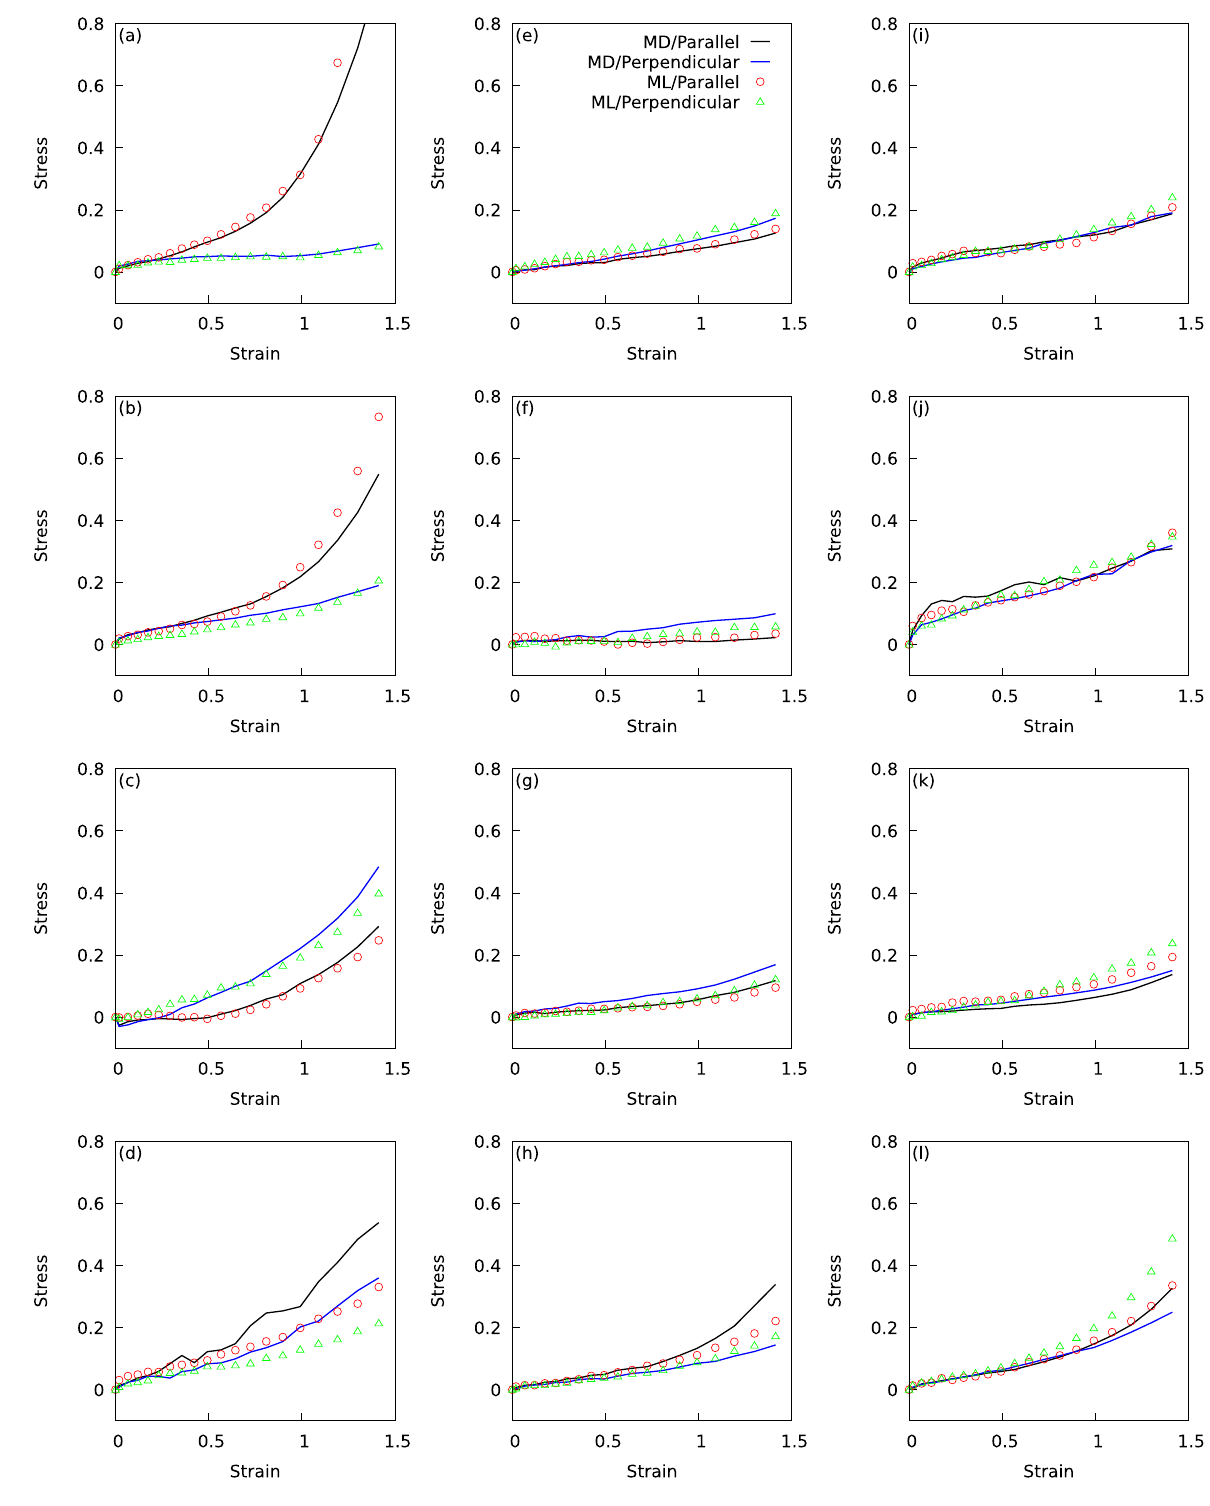
Figure 4. Comparison of the ML predictions and MD results for the stress–strain